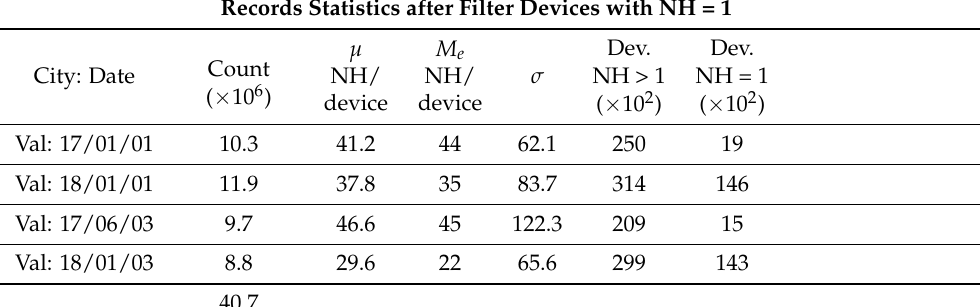
Table 4. Statistics of filtered data (devices with NH > 1), for Valparaíso (Val). A sample of four differ- ent